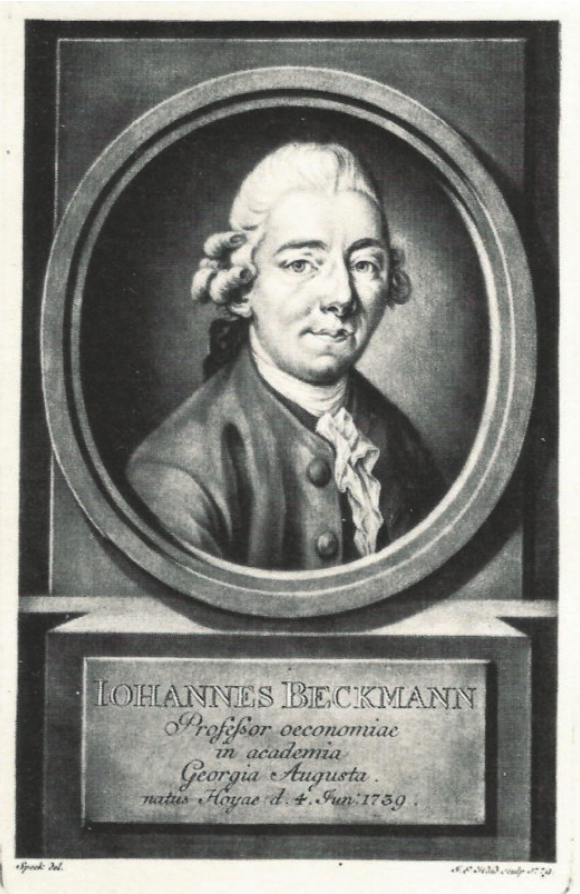
Figure 1. Johann Beckmann. Lithography by F. E. Haid. (Courtesy Johann-Beckmann-Gesellschaft,